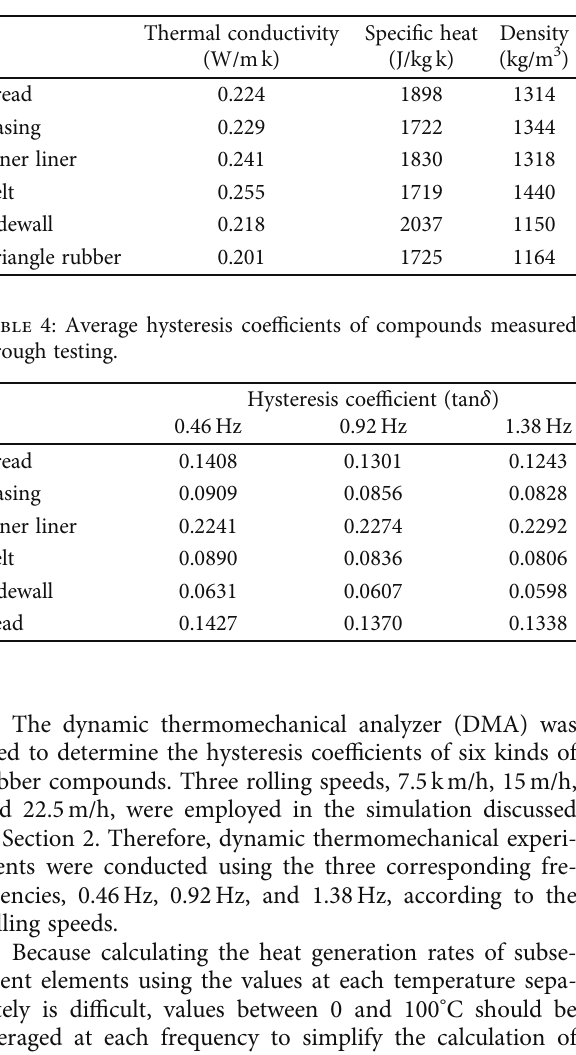
Table 3: Thermal performance characteristics of rubber.